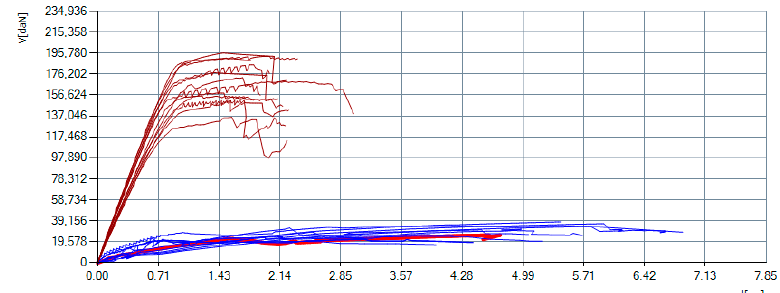
Figure 13. Capacity curves in X and Y directions.